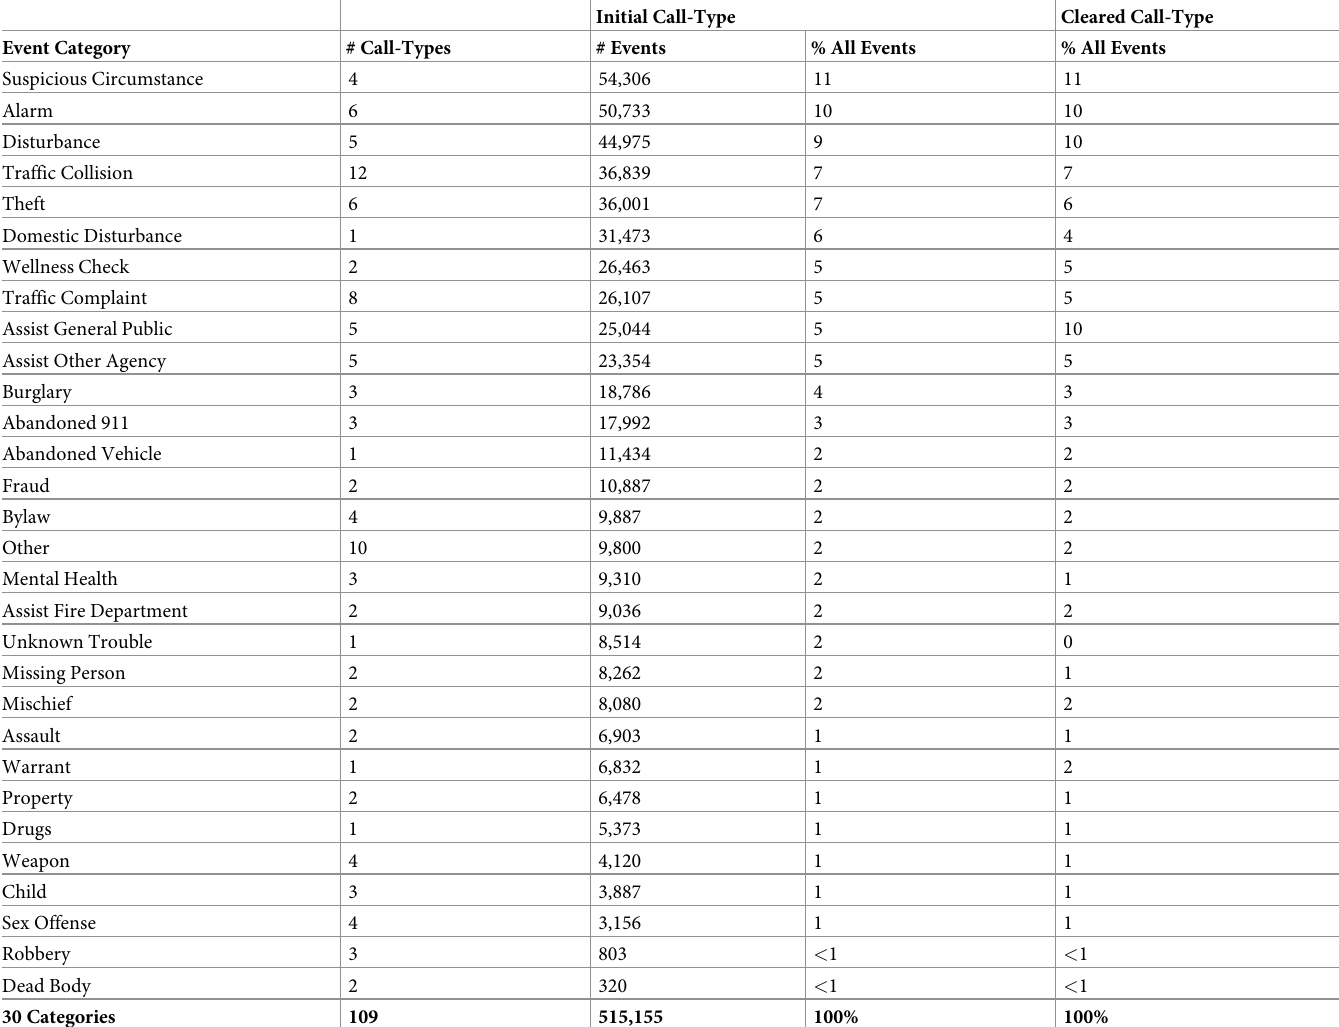
Table 1. Call-type categories and their descriptive